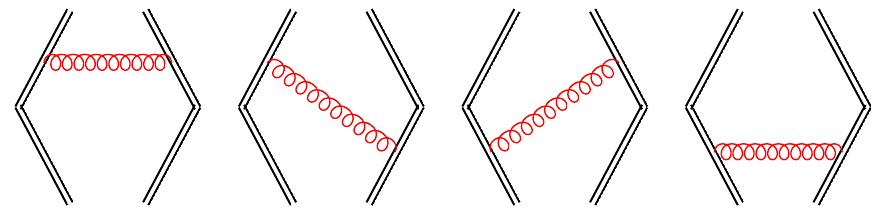
Figure 3 . The four possible radiation patterns for a dipole of two massive legs. From left to right: monopole correction to leg 1 corresponding to the term ( i; j ) = (1 ; 1) in (2.11), dipole correction (1 ; 2), dipole correction (2 ; 1), and monopole correction (2 ;